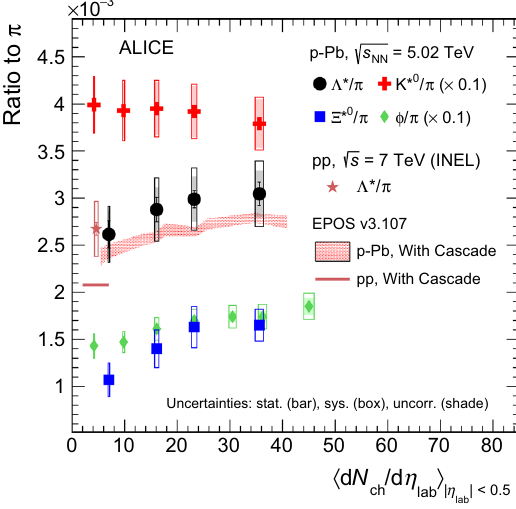
boxes) and multiplicity-uncorrelated (shaded boxes) systematic uncer- tainties. The EPOS3 model predictions [31–35] with statistical uncer- √ s = 7 TeV) and tainties are shown as horizontal bars (pp collisions at √ s NN = 5 . 02 TeV) shaded bands (p–Pb collisions at